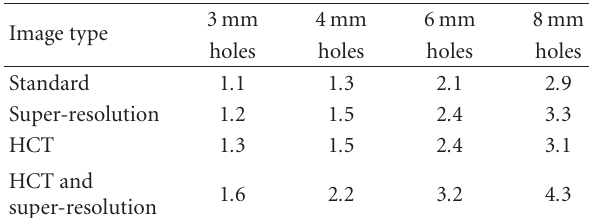
Table 2: Contrast ratios for the PET signals in the 3D AC brain- mode acquisition phantom